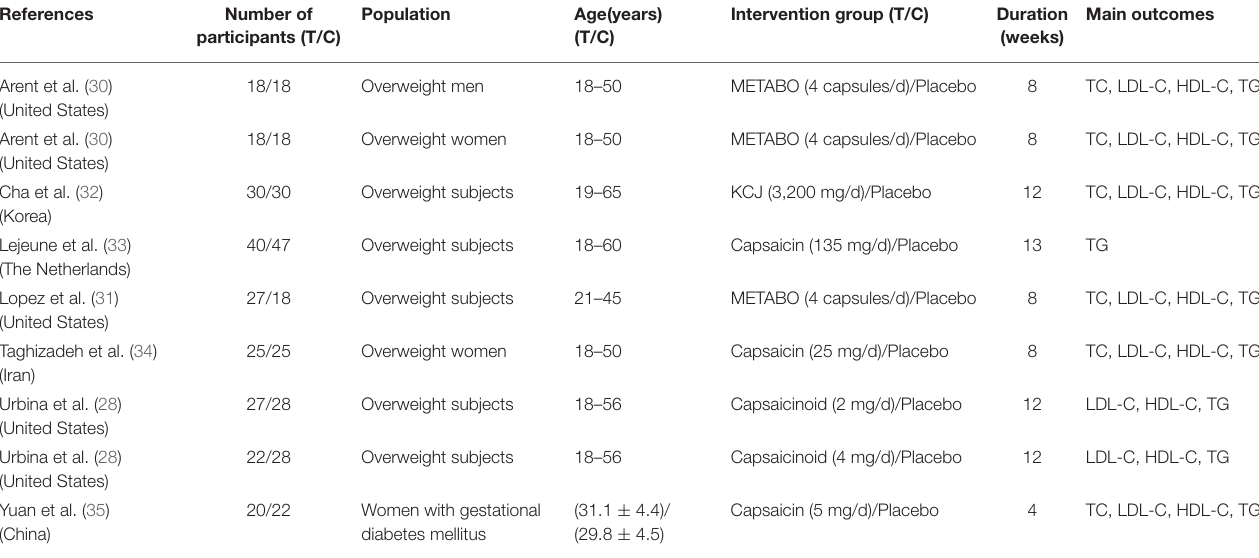
TABLE 1 | Characteristics of included capsaicin RCTs for